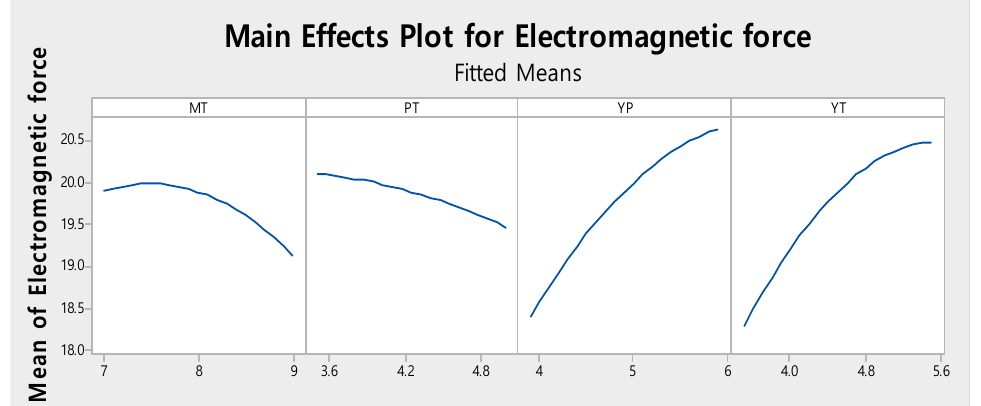
Figure 7. Main effects plot for electromagnetic force.